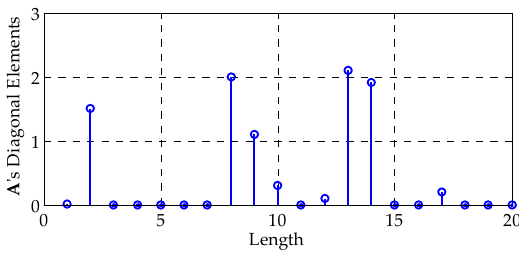
Figure 4. Illustration of the diagonal elements of matrix A .